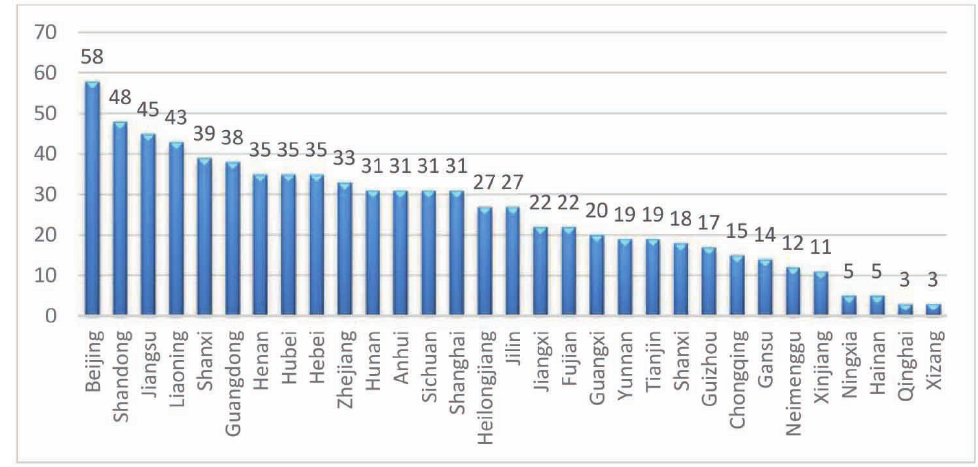
Figure 2: ThenumberofChinesenon-eliteuniversitiesindifferentprovinces